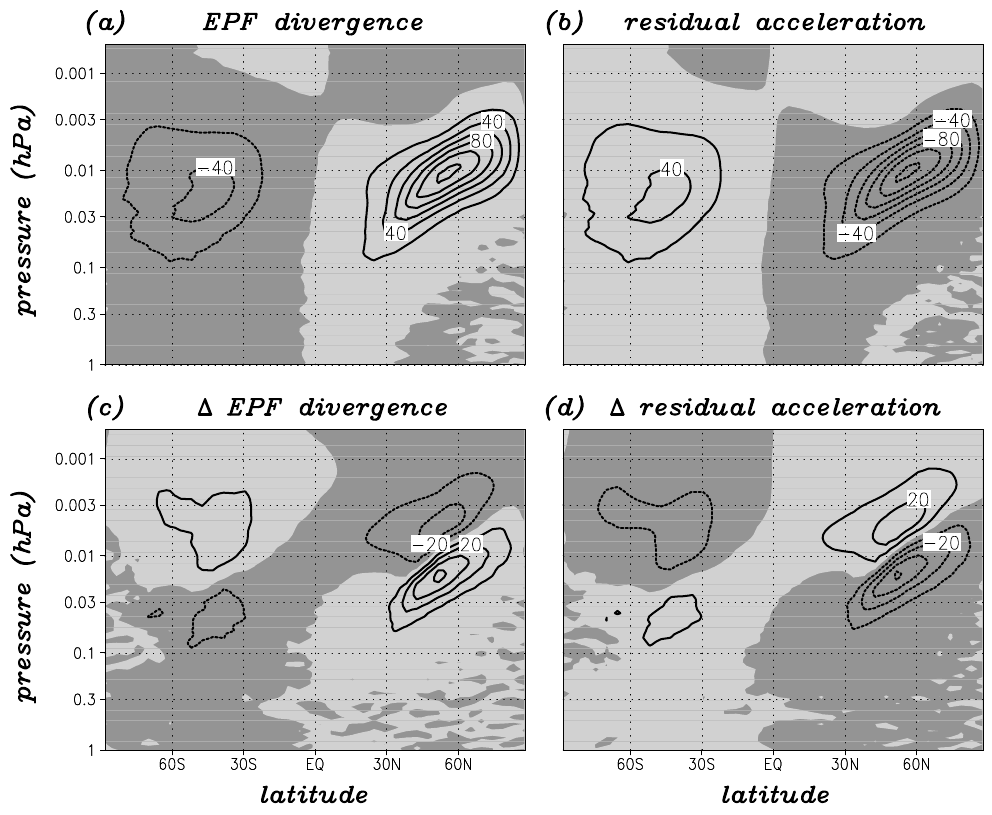
Fig. 6. Zonal-mean momentum budget in the residual picture. (a) Eliassen-Palm flux (EPF) divergence and (b) Coriolis force plus nonlinear advection associated with the residual circulation in the “July 2002” simulation (contour interval 20ms − 1 d − 1 ). (c) , (d) Same as (a), (b), but for the difference from the “normal July” run (contour interval 10ms − 1 d − 1 ). Zero contours are not drawn. Positive and negative values are indicated by light and dark shading.